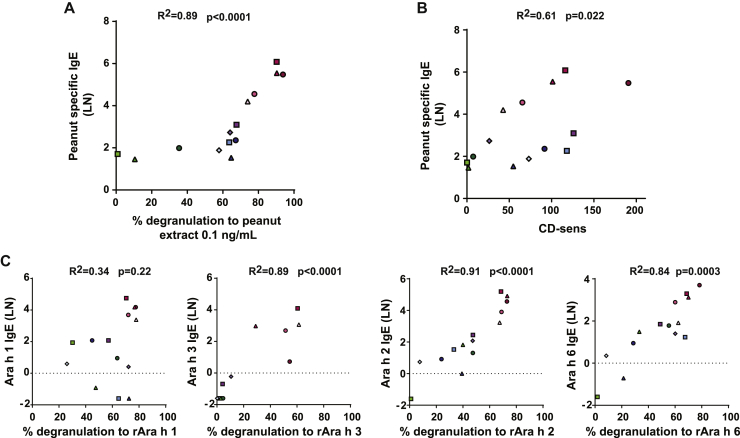
Correlation of serum Arachis hypogaea IgE measurements and hMC degranulation analysis in the panel of 14 patients with peanut allergy. Correlation of serum specific peanut IgE levels versus peanut extract–induced hMC degranulation (A), serum specific peanut IgE levels versus MC allergen CD-sens (B), and serum IgE levels specific for rAra h 1, rAra h 3, rAra h 2, and rAra h 6 versus hMC degranulation induced by the respective recombinant peanut allergen (C) are shown. IgE levels are expressed as natural logarithm (LN). Measurements noted as less than the limit of detection (<0.4) in Table E1 were given a value of half the limit of detection (0.2). CD-sens values were calculated as described previously by Johansson et al,25 with higher values implying greater sensitivity. Symbols indicate mean values for each investigated serum from patients with peanut allergy. Degranulation was measured based on surface expression of CD63 on hMCs by flow cytometry. Ara h IgE levels are expressed in natural logarithm (LN). Measurements noted as less than the limit of detection (<0.4) in Table E1 were given a value of half the limit of detection (0.2). Symbols indicate mean values for each investigated serum from patients with peanut allergy.